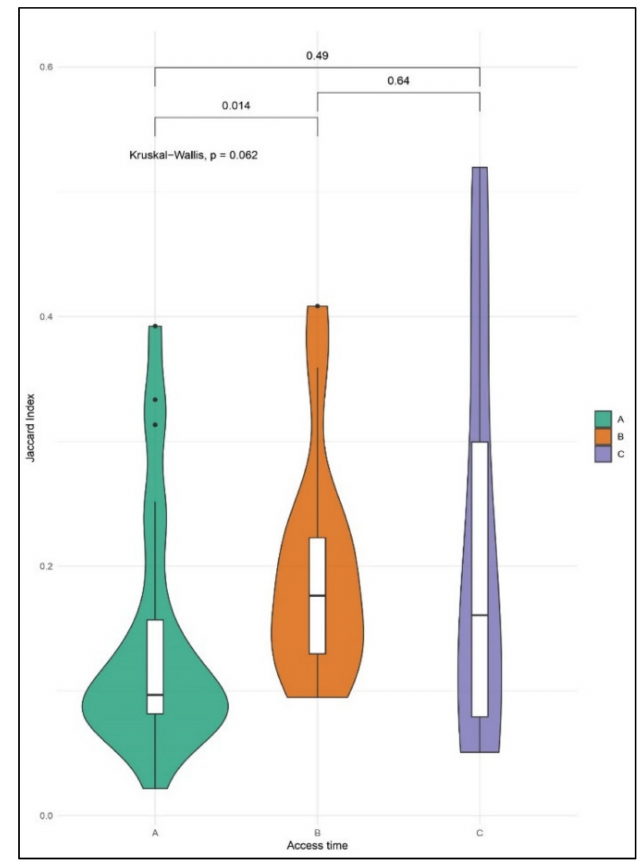
Figure 4. Violin plots showing the distribution of the Jaccard Indexes (JIs) computed by comparing the copy number alteration (CNA) profile of single circulating tumor cells (CTCs) and matched tumor tissue at the access times ( A ) ( n = 24), ( B ) ( n = 13) and ( C ) ( n =